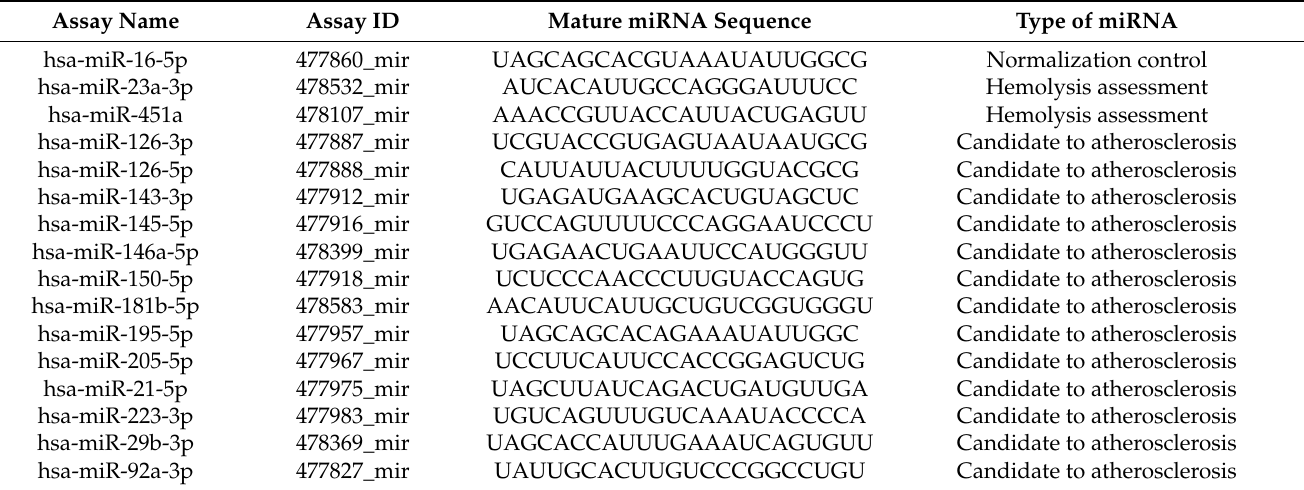
Table 1. List of the miRNA assays used for